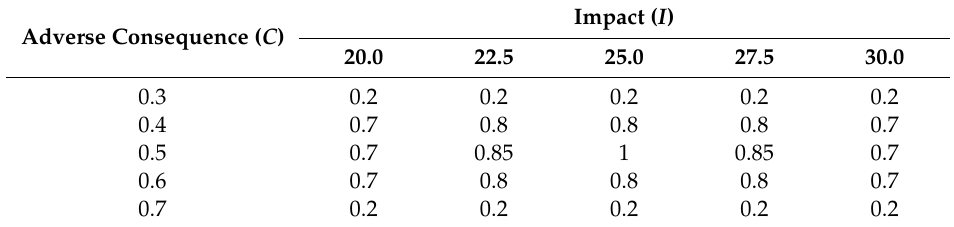
Table 7. Fuzzy relation Q ( C , I ) between medium adverse consequence ( C ) and medium impact ( I ). Adverse Consequence ( C )